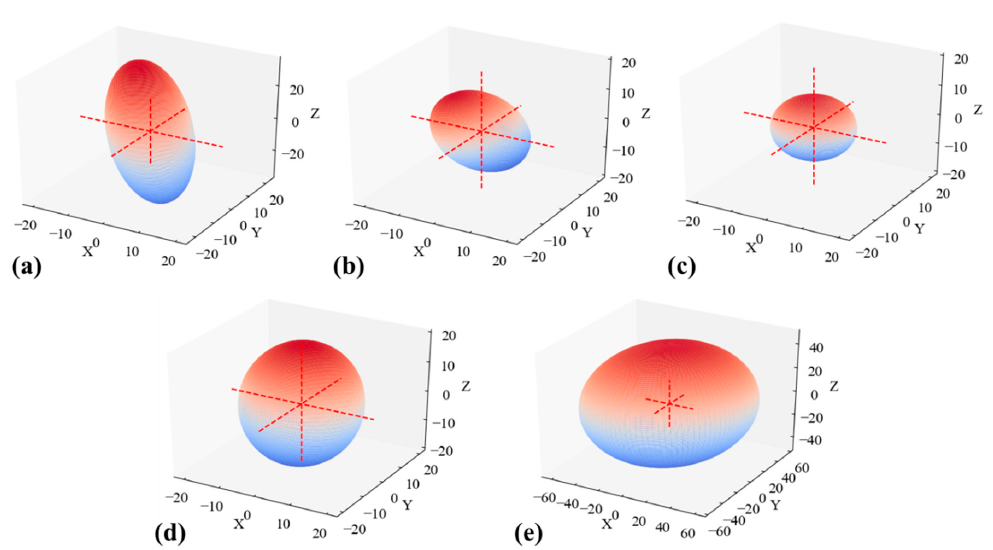
Figure A7. Ellipsoids according to Table A1 of ( a ) Sn-20 wt.% Bi ( b ) Sn-30 wt.% Bi ( c ) Sn-35 wt.% Bi ( d ) Sn-47 wt.% Bi ( e ) Sn-58 wt.% Bi.